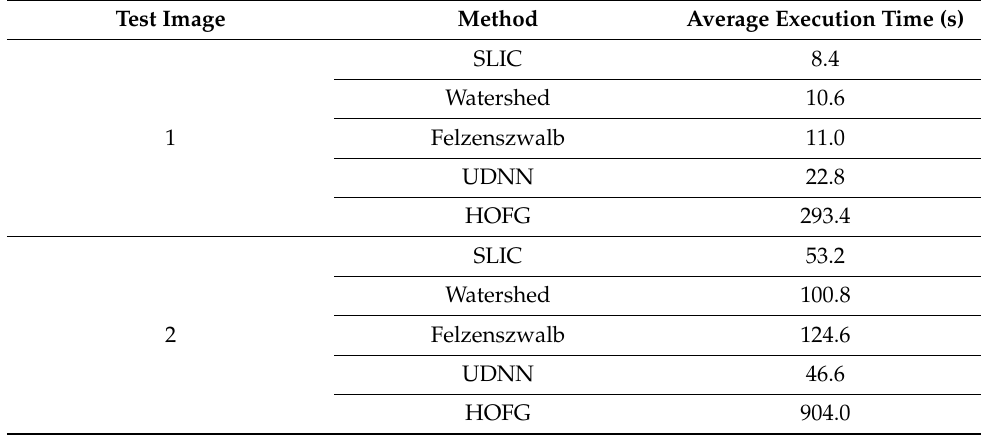
Table 5. Execution times of different algorithms on the remote sensing test